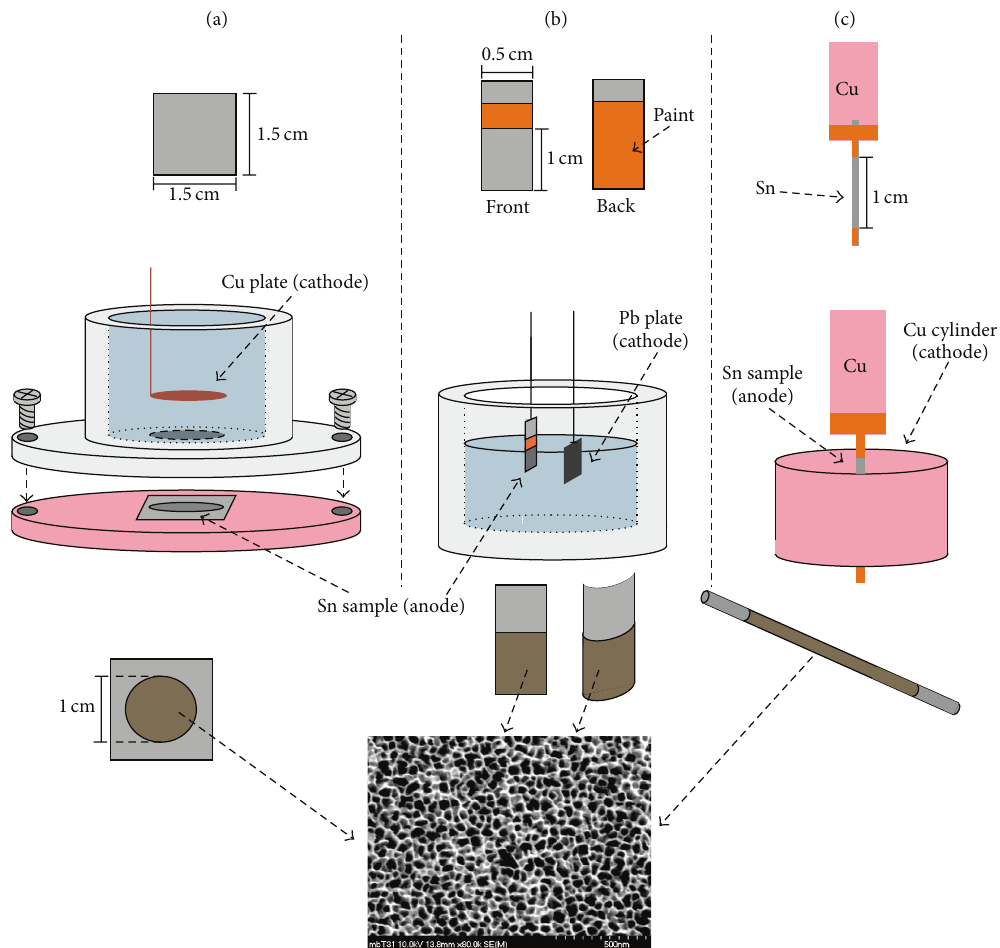
Figure 1: Schematic representation of experimental setups used for anodizing of Sn foils (a, b) and Sn wire (c).